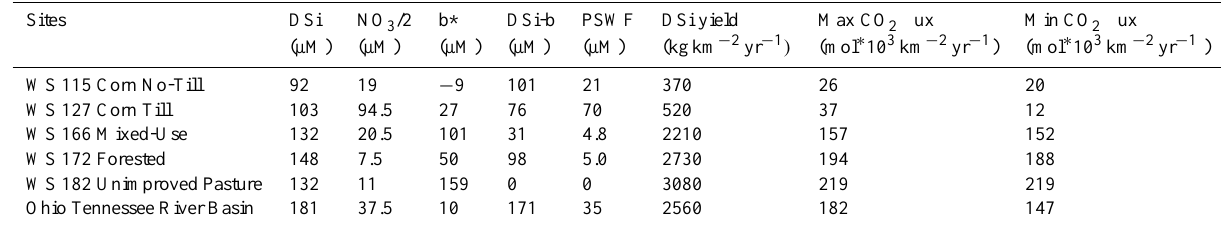
Table 4. Potential Silicate Weathered via Fertilizer (PSWF) calculated from Eq. (3). Total annual DSi yield for NAEW sites and the Ohio- Tennessee River Basin (DSi and NO 3 from Aulenbach et al., 2007). Maximum CO 2 consumption if all DSi is weathered via carbonic acid. Minimum CO 2 consumption =